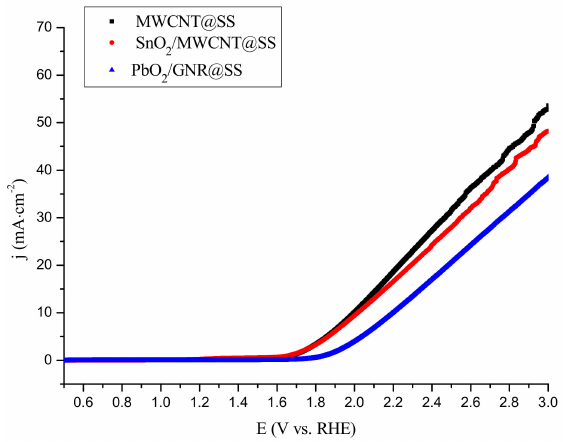
Figure 4. Linear sweep voltammograms of the MWCNT@SS, SnO 2 /MWCNT@SS, and PbO 2 /GNR@SS electrodes in 0.1 mol · L − 1 Na 2 SO 4 ; scan speed 10 mV · s − 1